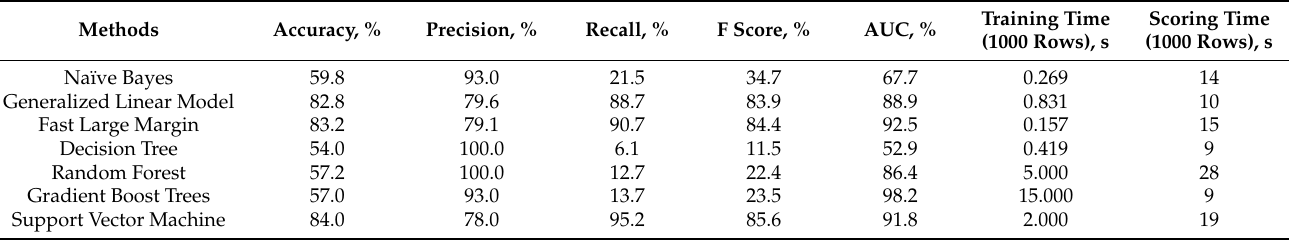
Table 3. Classification methods performance in the initial experiment to classify spam and phishing emails. Methods